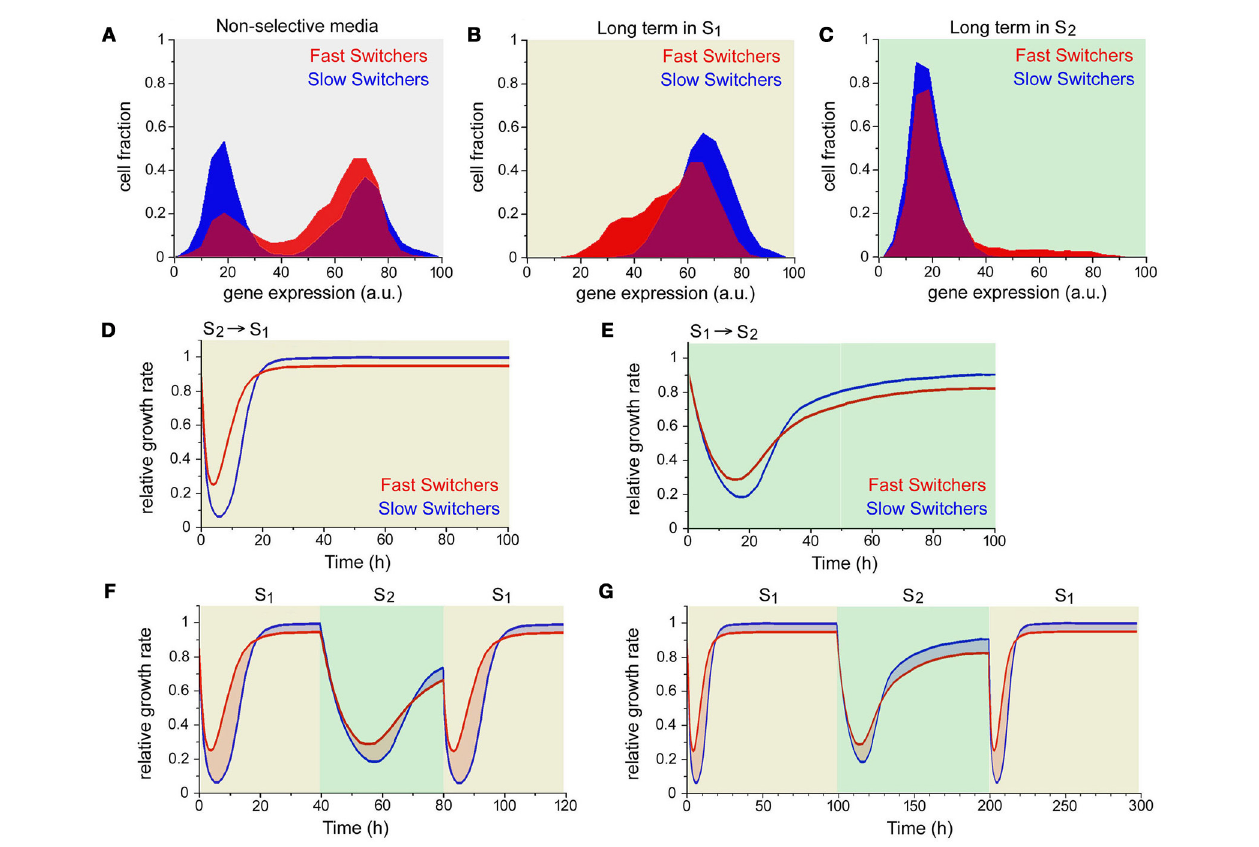
FIGURE 2 | Long term growth in a bet-hedging strategy. (A) Long term distribution of phenotypes (gene expression) for the slow switchers (blue) and fast switchers (red) in nonselective medium. Cells have mostly either high (ON) or low (OFF) expression. (B) In media without uracil (environment S1), only cells that are ON can grow, but the distributions are wide because cells are still switching. The distribution of fast switchers is wider because of a faster stream of cells switching off, resulting in a larger fraction of cells in the wrong state (red tail). (C) Conversely, in media with uracil and 5-FOA (environment S2) only OFF cells can grow, but the distribution is still wider for the fast switchers. (D) When changing from a long time (4 days) in S2 to S1, cells have low growth until the ON fraction grows. After some time, the slow switchers grow faster, because of the different fractions in the ON state shown in (B) . (E) When changing from a long time (4 days) in S1 to S2 cells have low growth until the OFF fraction grows. Again after some time, the slow switchers grow faster. (F) If media are alternated every 40min, this results in longer periods where the fast switchers grow faster than the slow switchers, leading to higher average growth. The total advantage can be visualized by the areas shaded in red vs. the areas shaded in blue. Intuitively, if the time is short the initial advantage of the fast switchers exceeds the eventual advantage of the slow switchers. (G) The opposite happens if the period is changed to 100min. Adapted from Acar et al. [